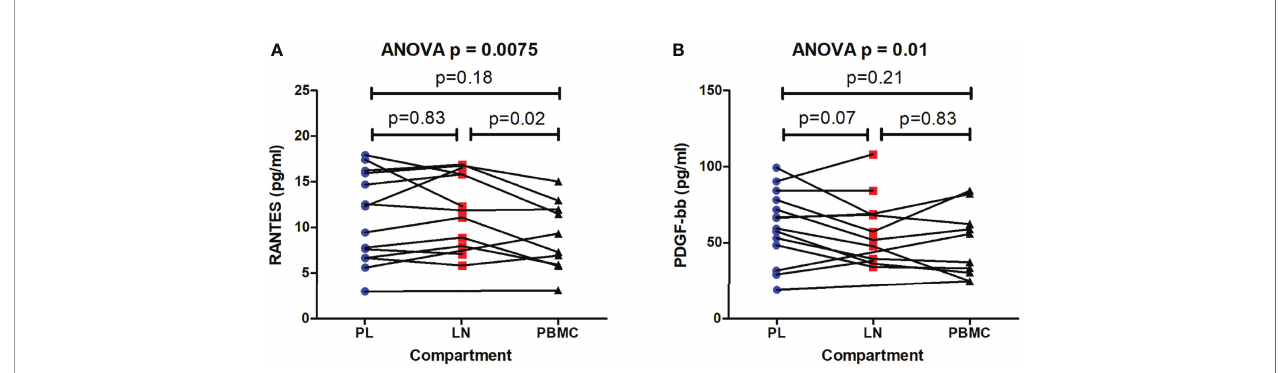
FIGURE 5 | Differing cytokine levels induced by viruses encoding gag-protease from pre-therapy plasma and the reservoir. Cytokines were measured in the supernatants of cell cultures infected with recombinant viruses encoding gag-protease from the lymph node (LN) and peripheral blood mononuclear cell (PBMC) reservoirs, as well as from the pre-therapy plasma (PL). Cytokines that differed signi fi cantly between cultures infected with viruses from different compartments, and were also signi fi cantly higher in infected cell cultures compared to uninfected cell culture controls, are shown, namely RANTES (A) , and PDGF-bb (B) . The overall repeated measures ANOVA p value is shown as well as the paired T test p values from two-way comparisons of the PL, LN and PBMC compartments. The average cytokine level in the supernatants of the uninfected cell controls was 4.796 pg/ml and 26.274 pg/ml for RANTES and PDGF-bb, respectively, and differed signi fi cantly from the average cytokine level in the supernatants of cell cultures infected with viruses from the different compartments (Student ’ s T test, p = 0.005 and p = 0.01,